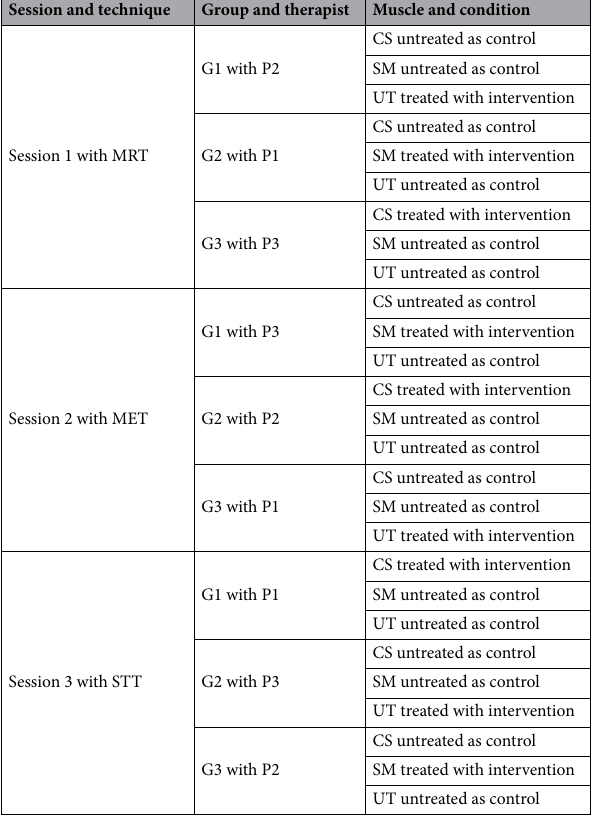
Table 1. Trial procedure. MRT = myofascial release technique; MET = muscle energy technique; STT = soft tissue technique; G1 = group 1; G2 = group 2; G3 = group 3; P1 = practitioner 1; P2 = practitioner